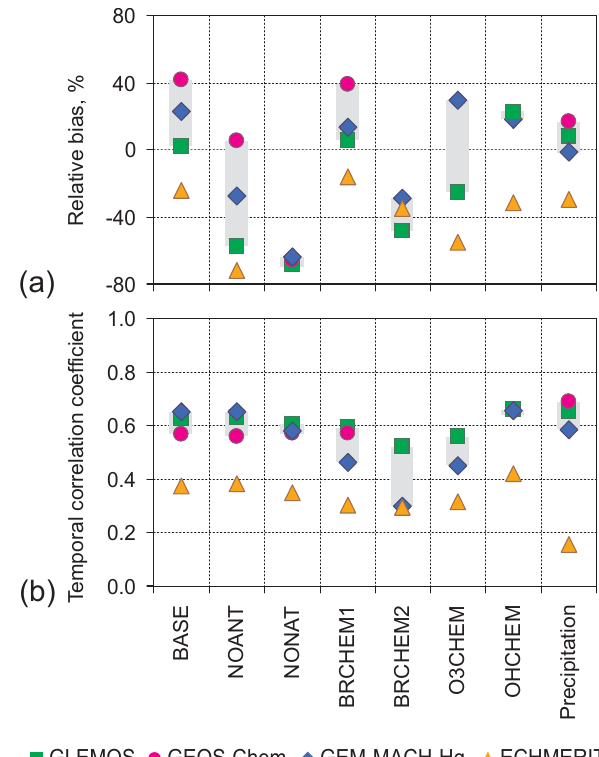
Figure 10. Relative bias (a) and spatial correlation coefficient (b) of simulated and observed annual mean wet deposition flux for dif- ferent model